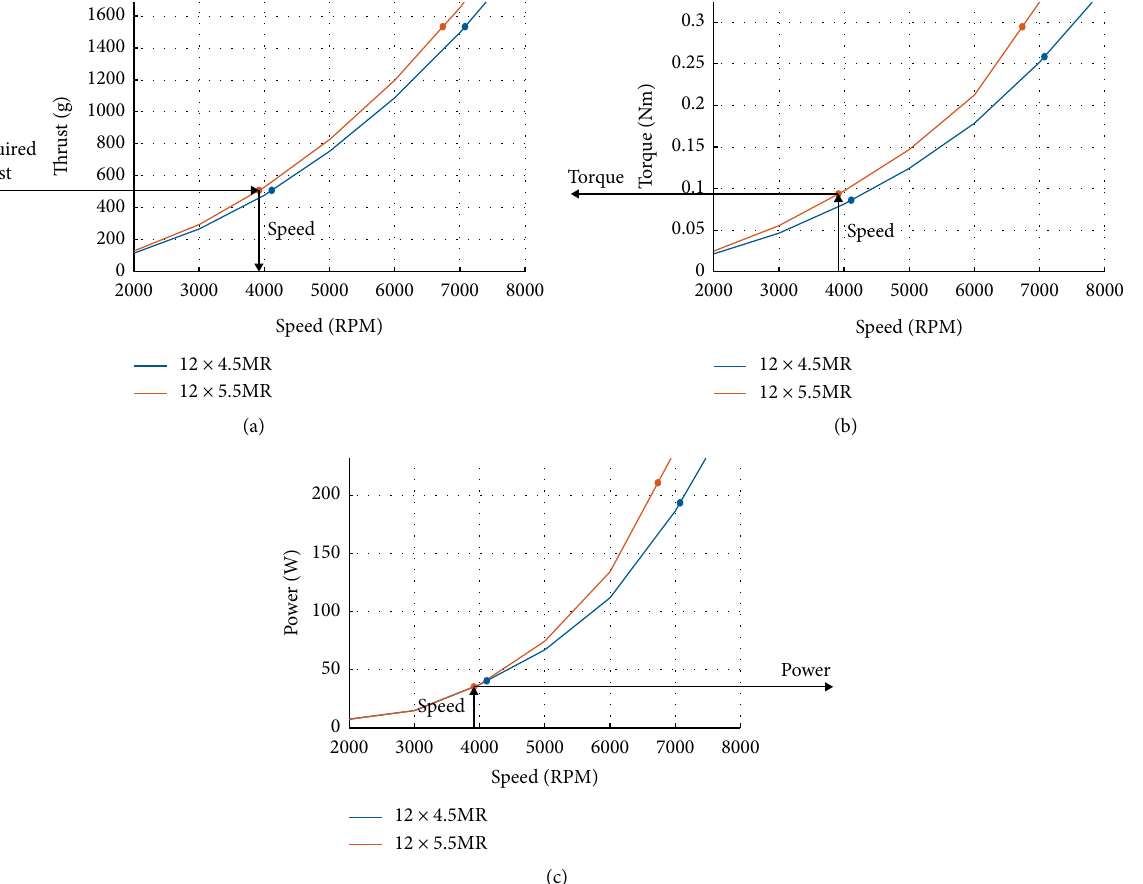
Figure 5: Example of obtaining a propeller operating point based on required thrust. (a) Obtaining speed from required thrust. (b) Obtaining torque from speed calculated in (a). (c) Obtaining power from speed calculated in